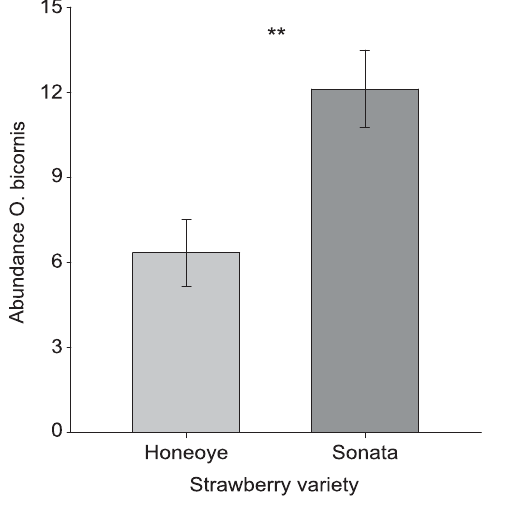
Figure 3. Abundance of O.bicornis females between strawberry varieties. Data show mean numbers ( 6 SE) of observed specimen per subunit. p , 0.05=significant.